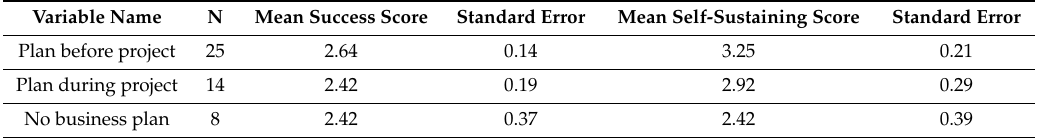
Figure 4. Box-plot showing a level of standards enacted and the coverage of target market (coverage